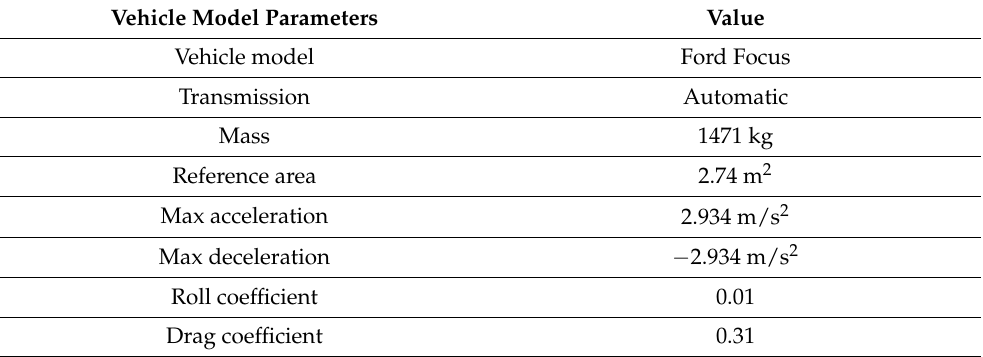
Table 3. Ego-vehicle’s parameter